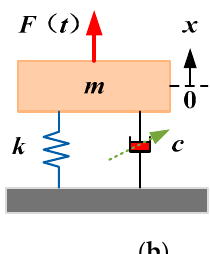
Figure 3. Typical schematic diagram of a semi–active vibration isolation system: ( a ) variable stiff- ness; ( b ) variable damping.